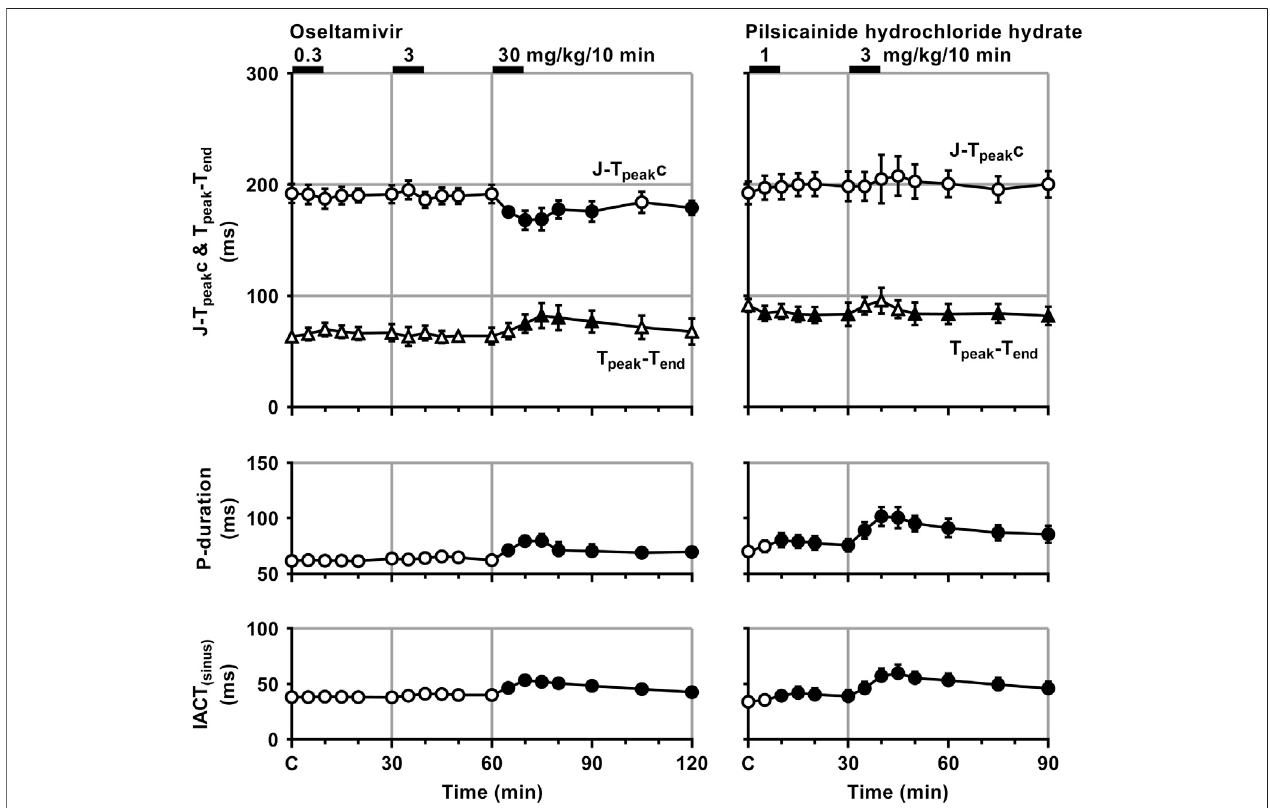
FIGURE 3 | Time courses of changes in the J-T peak c, T peak -T end , P-wave duration (P-duration) and inter-atrial conduction time (IACT) during sinus rhythm (IACT (sinus) )aftertheadministrationsofoseltamivir (left) andpilsicainidehydrochloridehydrate (right) .J-T peak wascorrectedbythefollowingformula:J-T peak c (cid:1) J-T peak / RR 0.58 withRRgivenin seconds (Johannesenet al., 2014).Dataare presented asmean ± S.E.M.(n (cid:1) 4for each drug). Closed symbols representsigni fi cantdifferences from their corresponding pre-drug basal control value (C) by p <